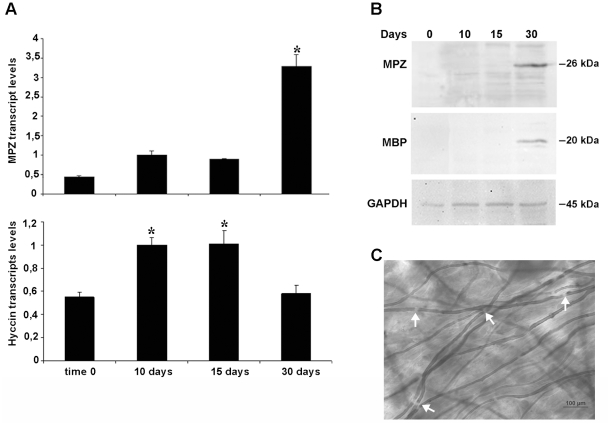
Hyccin expression levels in organotypic DRG cultures.Panel A: Cells were maintained in culture for the times indicated and analysis of MPZ mRNA was utilized as a reference for myelination in the culture. Results are expressed as mRNA fold increase relative to calibrator (10 days) normalized to housekeeping genes (b-actin and GAPDH) For each sample data are represented as means ±SEM (n = 3) and .p values were <0.05 compared to control. Panel B: Total cellular lysates were isolated at the times indicated and subjected to immunoblot analysis for the myelin markers MPZ and MBP. An antibody against GAPDH was used as an internal control. Panel C: At 30 days cell cultures were fixed, stained with 1% Sudan Black in 70% ethanol and analyzed by optic microscopy. Bright-field micrographs confirm the presence of myelin sheaths with Ranvier nodes (white arrows) surrounding th axons.